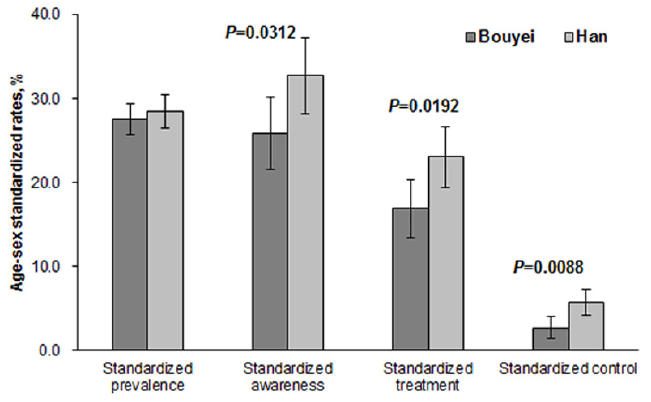
Figure 1. Standardized rates of prevalence, awareness, treatment, and control in Bouyei and Han. Considering the fact that high BP was critically dependent on age and sex, subgroup comparisons were conducted in age/sex strata with clustered effect taken into account (Table S2).